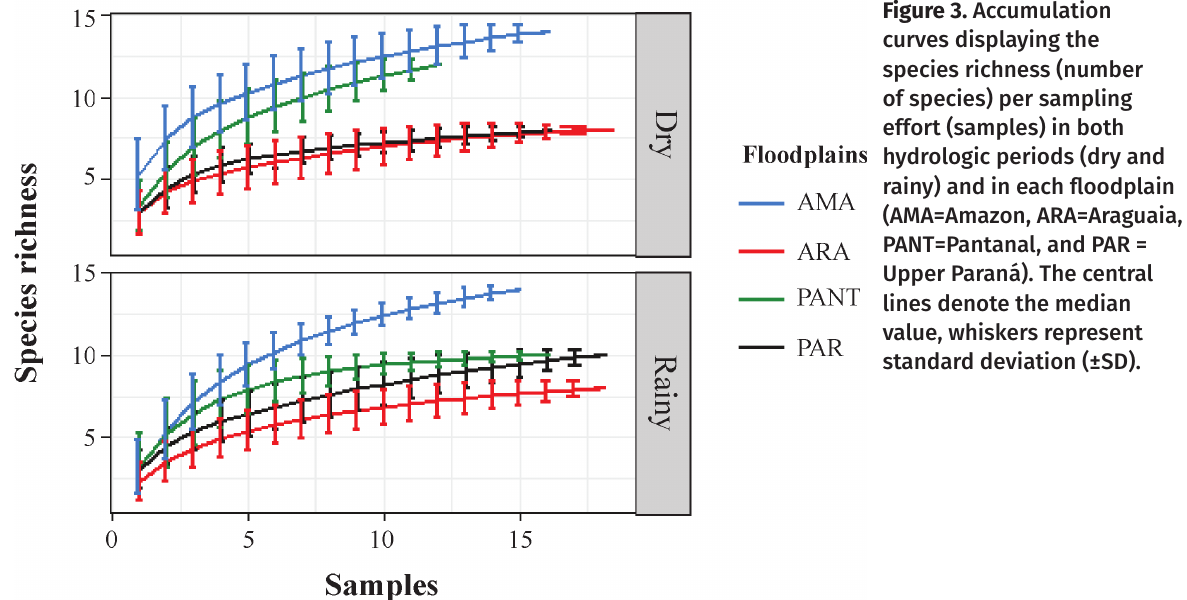
Figure 3. Accumulation curves displaying the species richness (number of species) per sampling effort (samples) in both hydrologic periods (dry and rainy) and in each floodplain (AMA=Amazon, ARA=Araguaia, PANT=Pantanal, and PAR = Upper Paraná). The central lines denote the median value, whiskers represent standard deviation